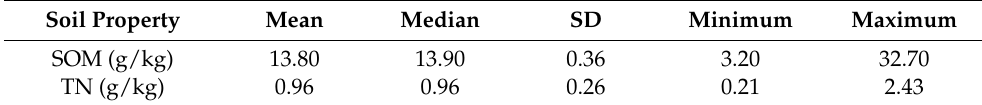
Table 1. SOM and TN statistical characteristics of soil samples in Quzhou County. Soil Property